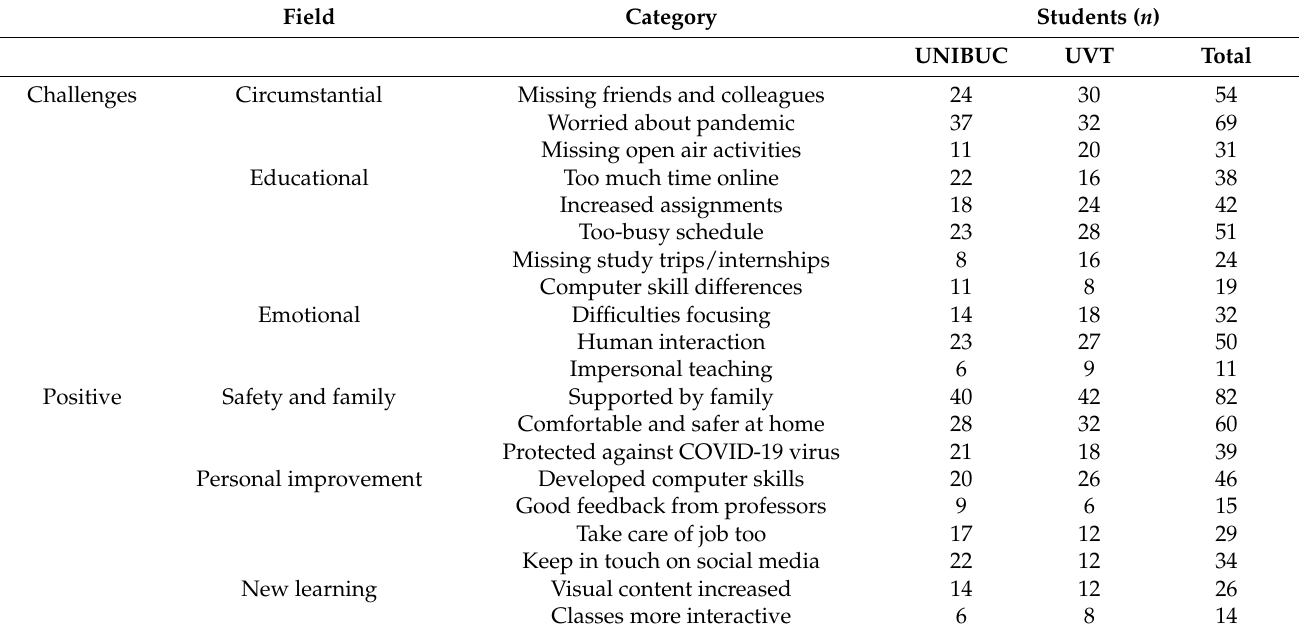
Table 3. Qualitative data